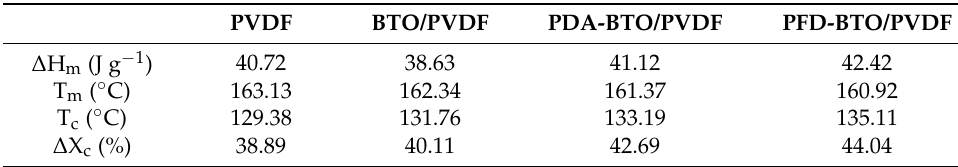
Figure 5. FT-IR spectra of the as-printed pure PVDF, BTO/PVDF, PDA-BTO/PVDF and PFD-BTO/PVDF films with a wavenumber range of ( a ) 3100 to 2900 cm − 1 and ( b ) 1220 to 1120 cm − 1 . DSC ( c ) melting and ( d ) crystallization curves of the as-printed samples. Table 1. Enthalpies of fusion ( ∆ H m ), melting temperature (T m ), crystallization temperature (T c ) and percentage of crystallinity ( ∆ X c ) of PVDF-based